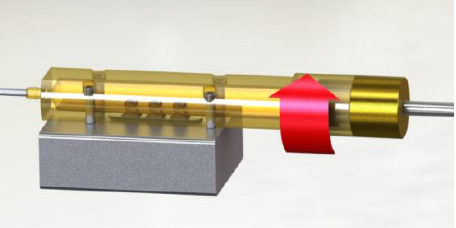
Figure 17. Clockwise rotation around the x axis of the